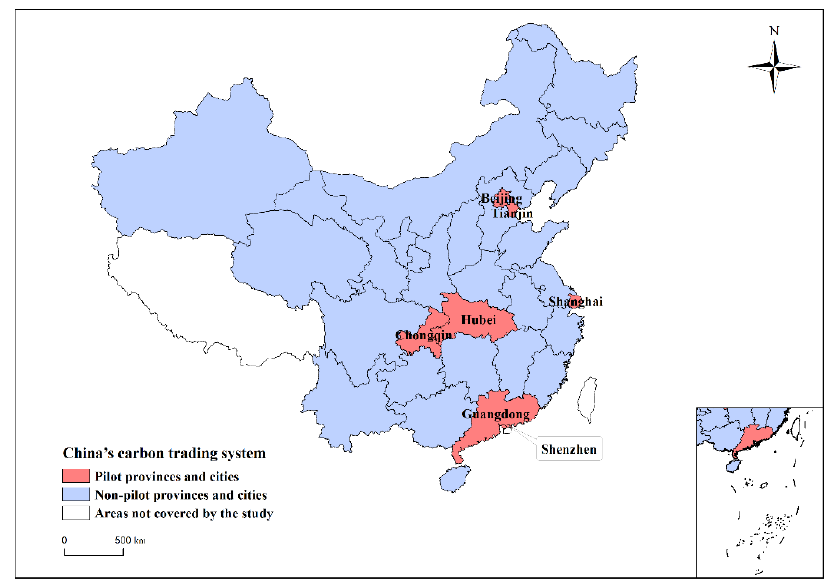
Figure 1. Distribution of pilot and non-pilot provinces and cities of carbon trading system in China.